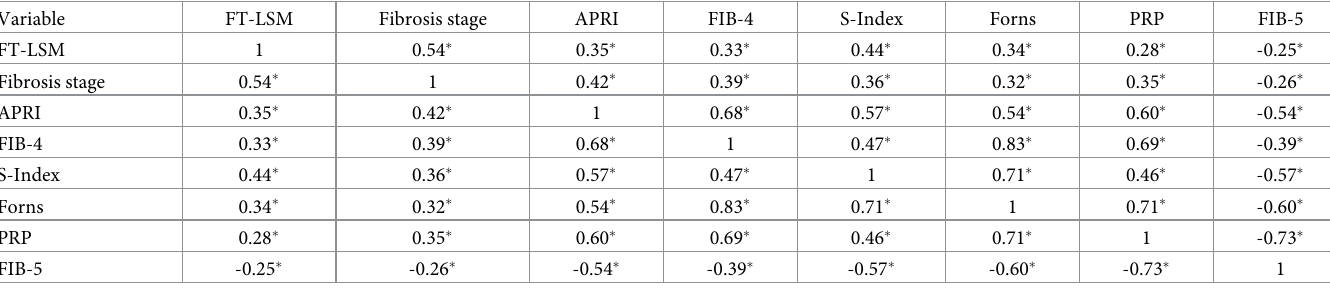
Table 2. The correlation among fibrosis stage, serological model, and